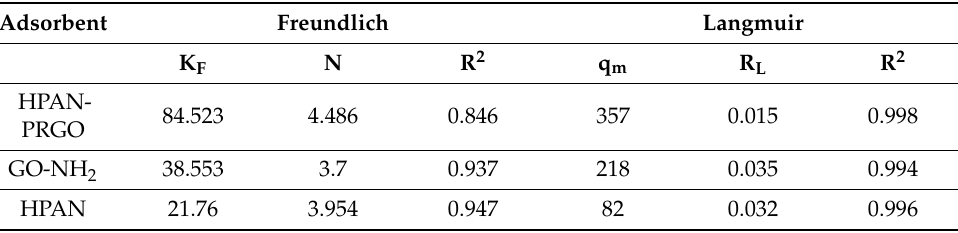
Table 1. Freundlich and Langmuir adsorption isotherms’ different parameters for Sm 3+ adsorption over synthesized nanomaterials.